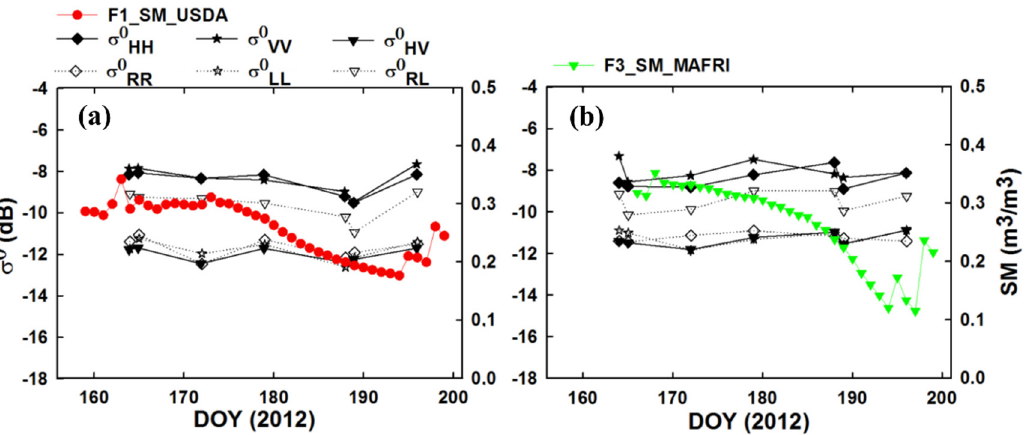
Figure 6. Temporal profile of C-band linear (HH, VV, and HV) and circular (RR, LL, and RL) polarized backscattering along with soil moisture measurements (F1_SM_USDA and F3_SM_MAFRI) over (a) F1 and (b) F3 sites.